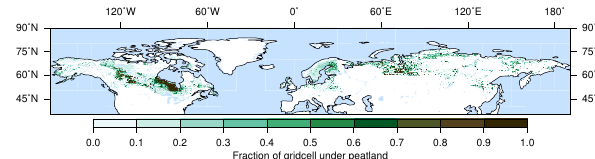
Fig. 2. Fraction of land covered by northern peatlands at present (Tarnocai et al., 2007, 2009).